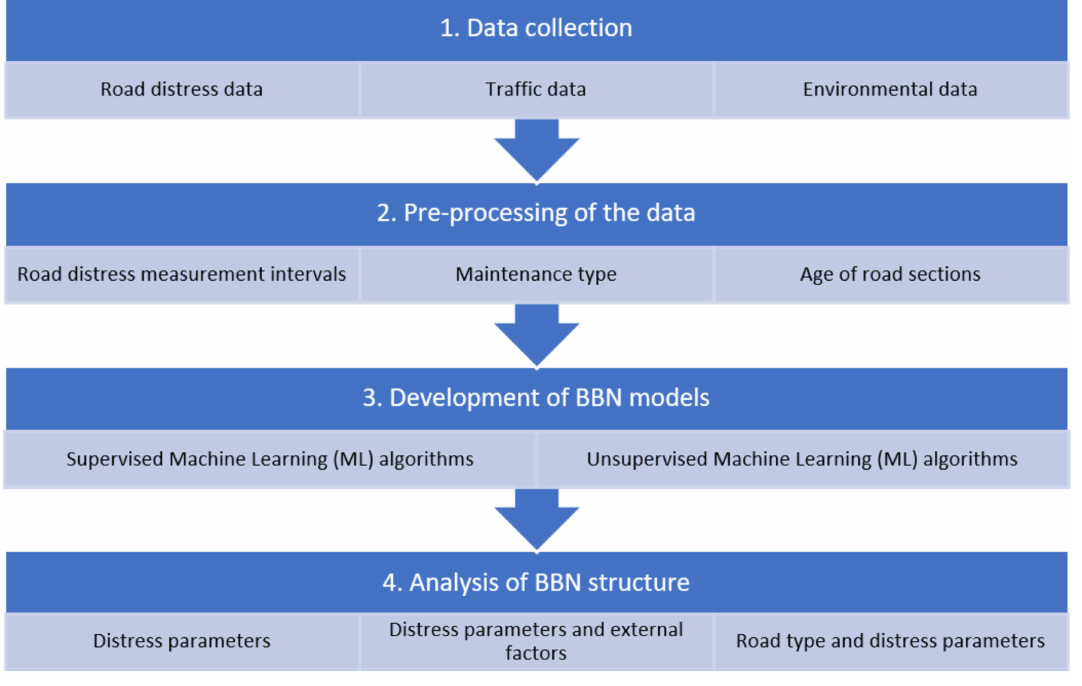
Figure 3. Methodology of the